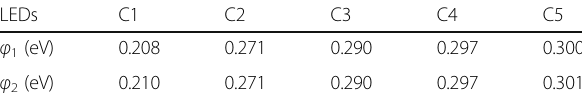
Table 4 Valence band barrier height for each PNP-AlGaN junction of LEDs C1, C2, C3, C4, and C5